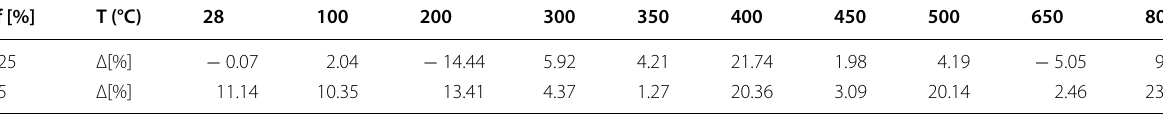
Table 8 Percent errors of the predicted tenisle strength by Eq.